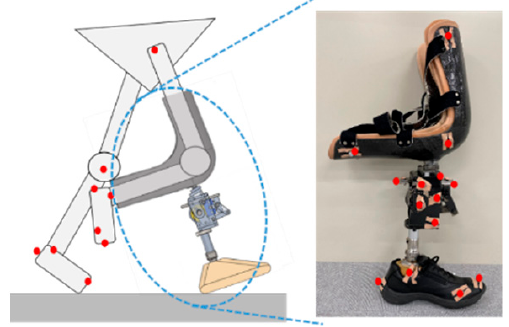
Figure 5. Marker placement on the body and prosthetic knee.